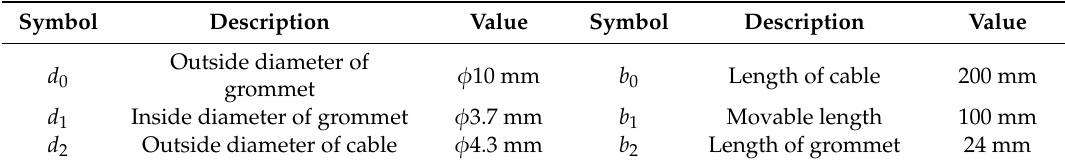
Figure 9. Schematic of grommet and cable used for bonding force test.